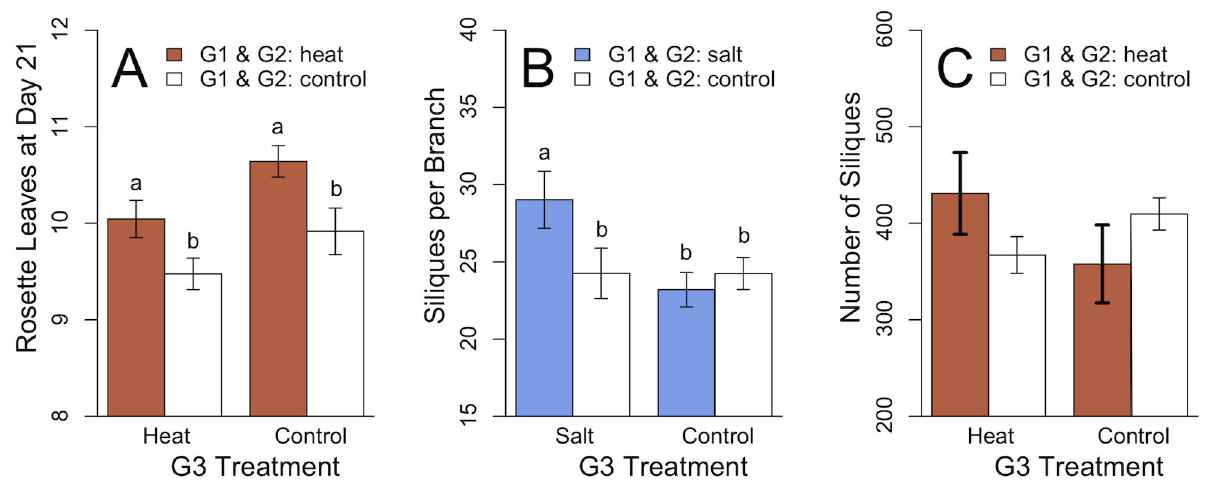
Figure 5. Transgenerational effects of two stress generations displaying three different modes of adaptation to novel environments. A: Tracking: in genotype Sha two generations of ancestral heat treatment (orange) led to more rosette leaves after three weeks in comparison to ancestral control treatment (white). B: Transgenerational phenotypic plasticity: in genotype Sha, two generations of ancestral salt treatment (blue) led to increased number of siliques per branch when compared to ancestral control conditions (white) under G3 salt conditions, but not G3 control conditions. C: Diversified bet-hedging: in genotype Cvi ancestral heat treatment (orange) increased the variance of total siliques in comparison to ancestral control treatment (white).